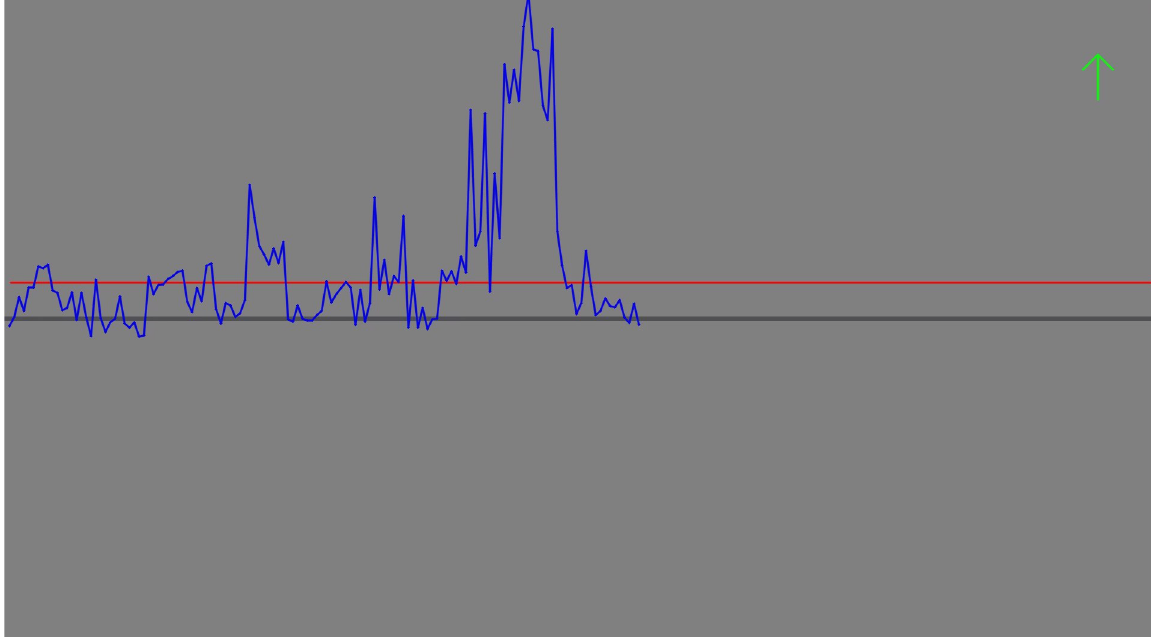
Fig 2. Example NF training feedback. Example 30-s single trial of NF modulation, partially completed. The black line is 0 dB, the red line is the goal threshold, the blue line is the feedback signal, and the green arrow is the up-regulation instruction